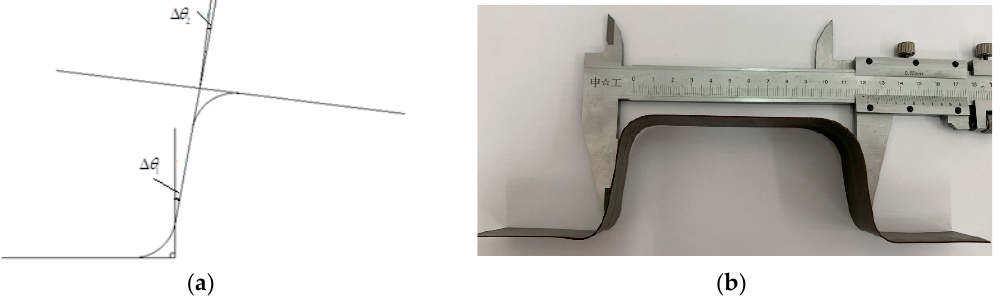
Figure 12. Friction coefficient curve under different loads and function fitting curve: ( a ) Spring-back angle; ( b ) True spring-back measurement.